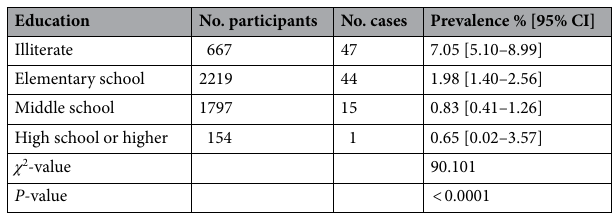
Table 2. Prevalence of cystic echinococcosis by education level in Xiaonangou township in 2011. CI: confidence